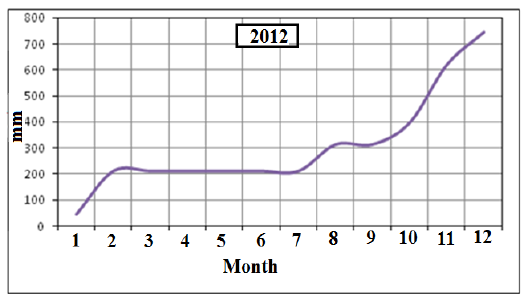
Fig 5. The graph of monthly rainfall in the study